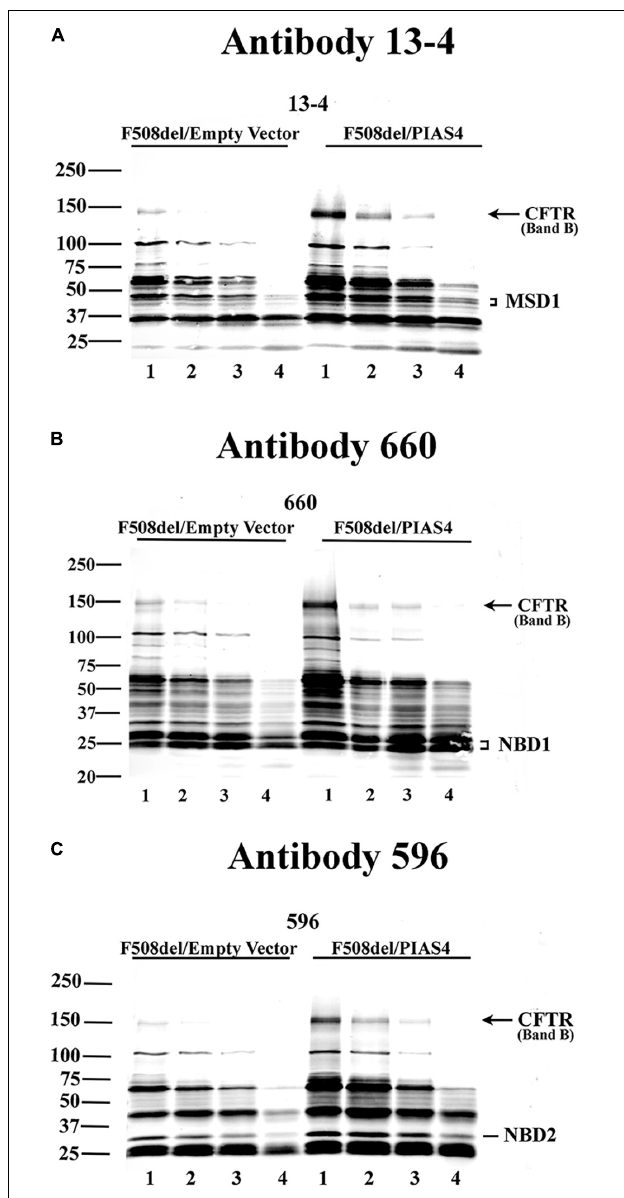
FIGURE 2 | The impact of PIAS4 on the protease sensitivity of F508del CFTR. Microsomal vesicles were isolated from transfected CFBE-F508del cells and subjected to cellular disruption as described in the “Materials and Methods” section. The microsomal pellet was subjected to 20, 40, 80, or 240 µ g/ml TPCK trypsin, lanes 1–4, respectively, for 15 min each, resolved on 7%/12% step gels and transferred. (A) Proteins were blotted with CFTR monoclonal 13-4 targeting the CFTR N-terminus. PIAS4 augmented band B expression and protected CFTR tryptic fragments generated by trypsin-mediated hydrolysis. Quantitation of the 13-4 gel yielded relative density values: at MW bands of 50–75 kDa, for control: 1.0, 0.54, 0.34, and 0.056; and for PIAS4 treated: 1.0, 0.80, 0.40, and 0.11. Density at MW bands ∼ 40–50 kDa for control: 1.0, 0.56, 0.40, and 0.16; and for PIAS4 treated: 1.0, 0.75, 0.46, and 0.29. (B,C) Other anti-CFTR monoclonals gave qualitatively similar results that identified fragment patterns for NBD1 (Ab #660) or NBD2 (Ab #596), respectively, which also provided evidence of protease protection. Thus, the densities of identifiable domains of F508del CFTR were increased for all fragments, as PIAS4 stabilized domain fragments against protease activity.